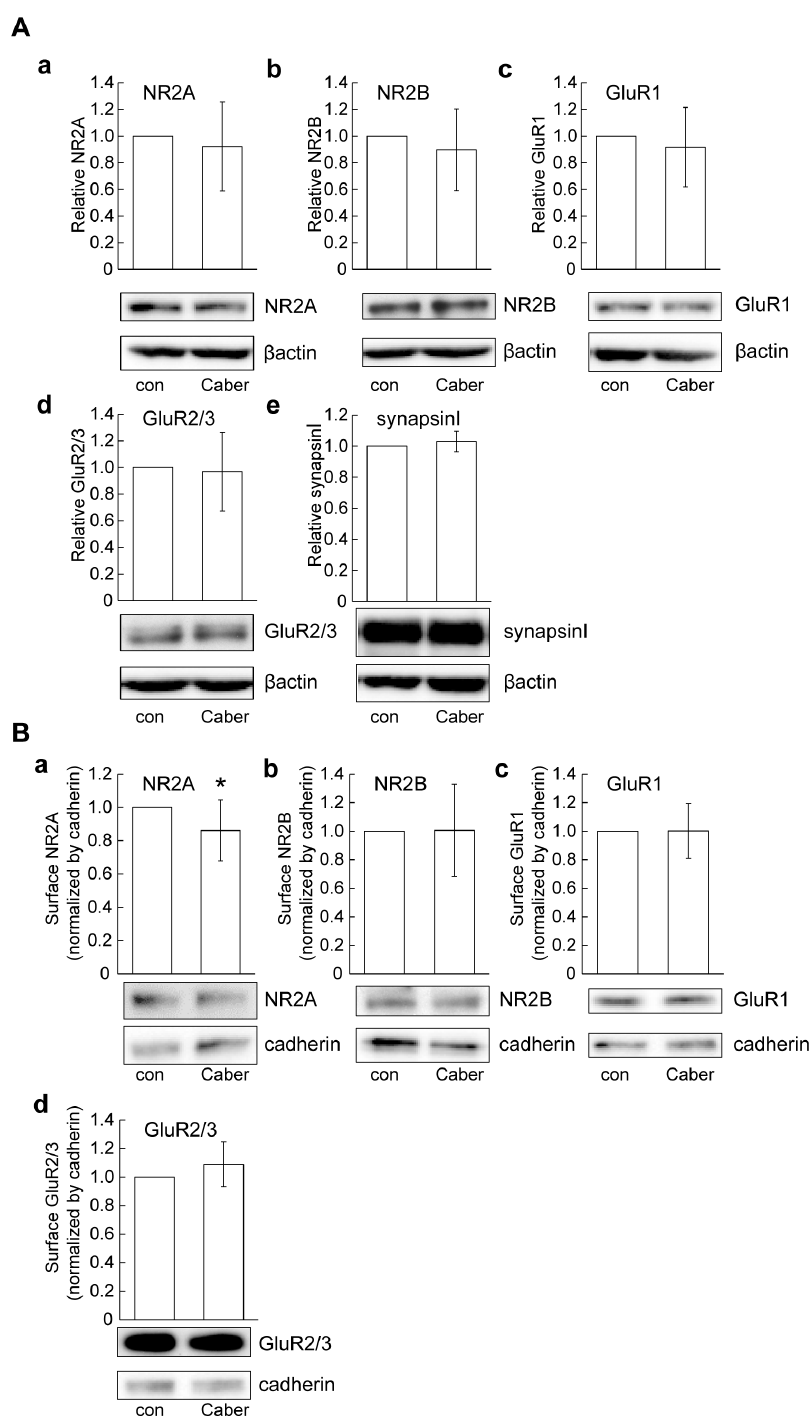
Figure 6. Levels of cell surface and total expression of glutamate receptors after cabergoline treatment. (A) No change in total expression levels of glutamate receptor subunits after cabergoline treatment. Total expression levels of NR2A, NR2B, GluR1, GluR2/3 and synapsinI after cabergoline treatment (10 m M for 24 hours). SynapsinI: pre-synaptic protein. Upper : Quantification of each protein was carried out. All data represent mean 6 SD (n=8). Statistics determined by t -test. (B) Cell surface expression levels of NR2A, NR2B, GluR1 and GluR2/3. Uppe r: Quantification of each protein was performed by normalizing to expression of cadherin (cell surface protein). All data represent mean 6 SD (NR2A: n=9, NR2B: n=6, GluR1, GluR2/3: n=8). * P , 0.05 vs. - Caber (t-test).